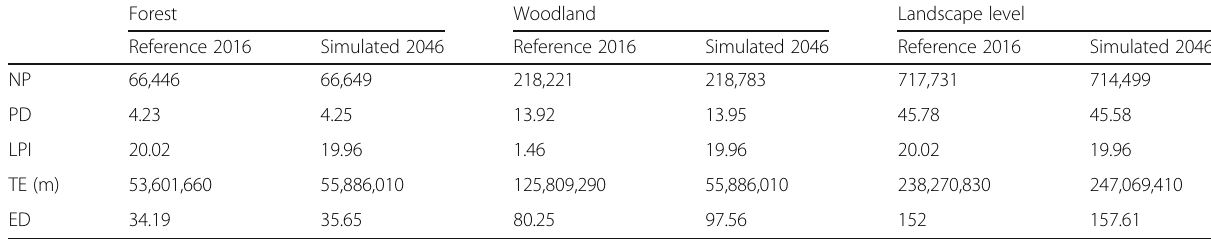
Table 6 Simulated class level fragmentation in BER Forest Woodland Landscape